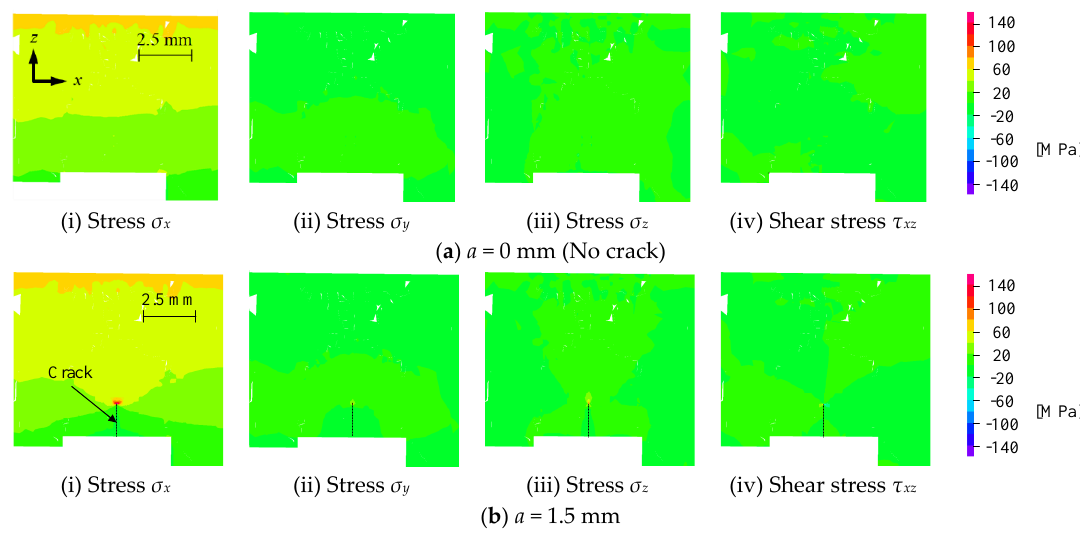
Figure 14. The stress σ x , σ y , σ z , and shear stress τ xz distribution above the cooling passage of Model 3D, a = 0, 1.5 mm. ( a ) a = 0 mm (No crack); ( b ) a = 1.5 mm.